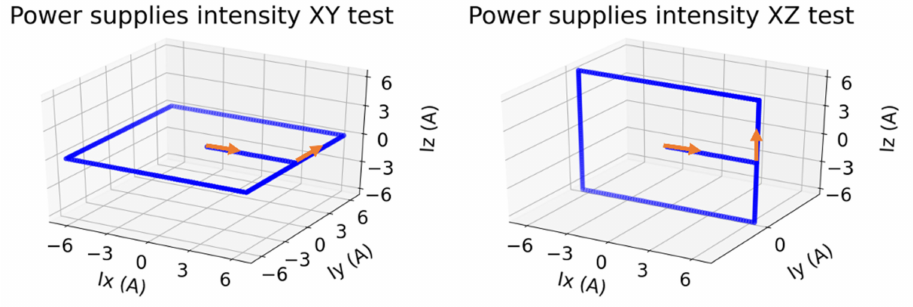
Figure 4. Power supply intensity values for the rotation test. The left side shows information for the test around the z -axis, whereas the right side shows information for the test around the y -axis. Ix represents intensity applied on the x -axis coil, Iy the intensity applied on the y -axis coil and Iz the intensity applied on z -axis coil. Orange arrows show the direction of